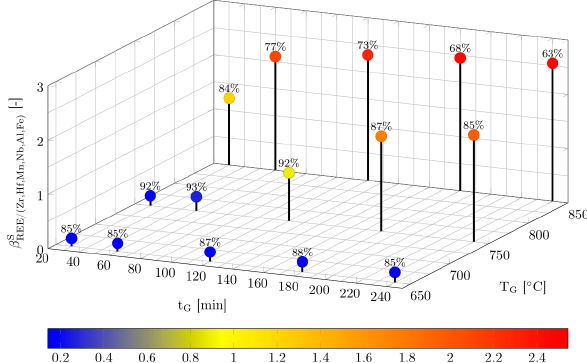
Figure 3. Effect of roasting temperature and roasting time on separation factor (y-axis, colored bar) and leaching yields of REEs in percent ( (cid:1866) H + /(cid:1865) conc. = 15 mmol/g; ϱ PD,L = 25 kg/m 3 ; T L = 20 °C; t L = 24 h; r R,L = 300 rpm).